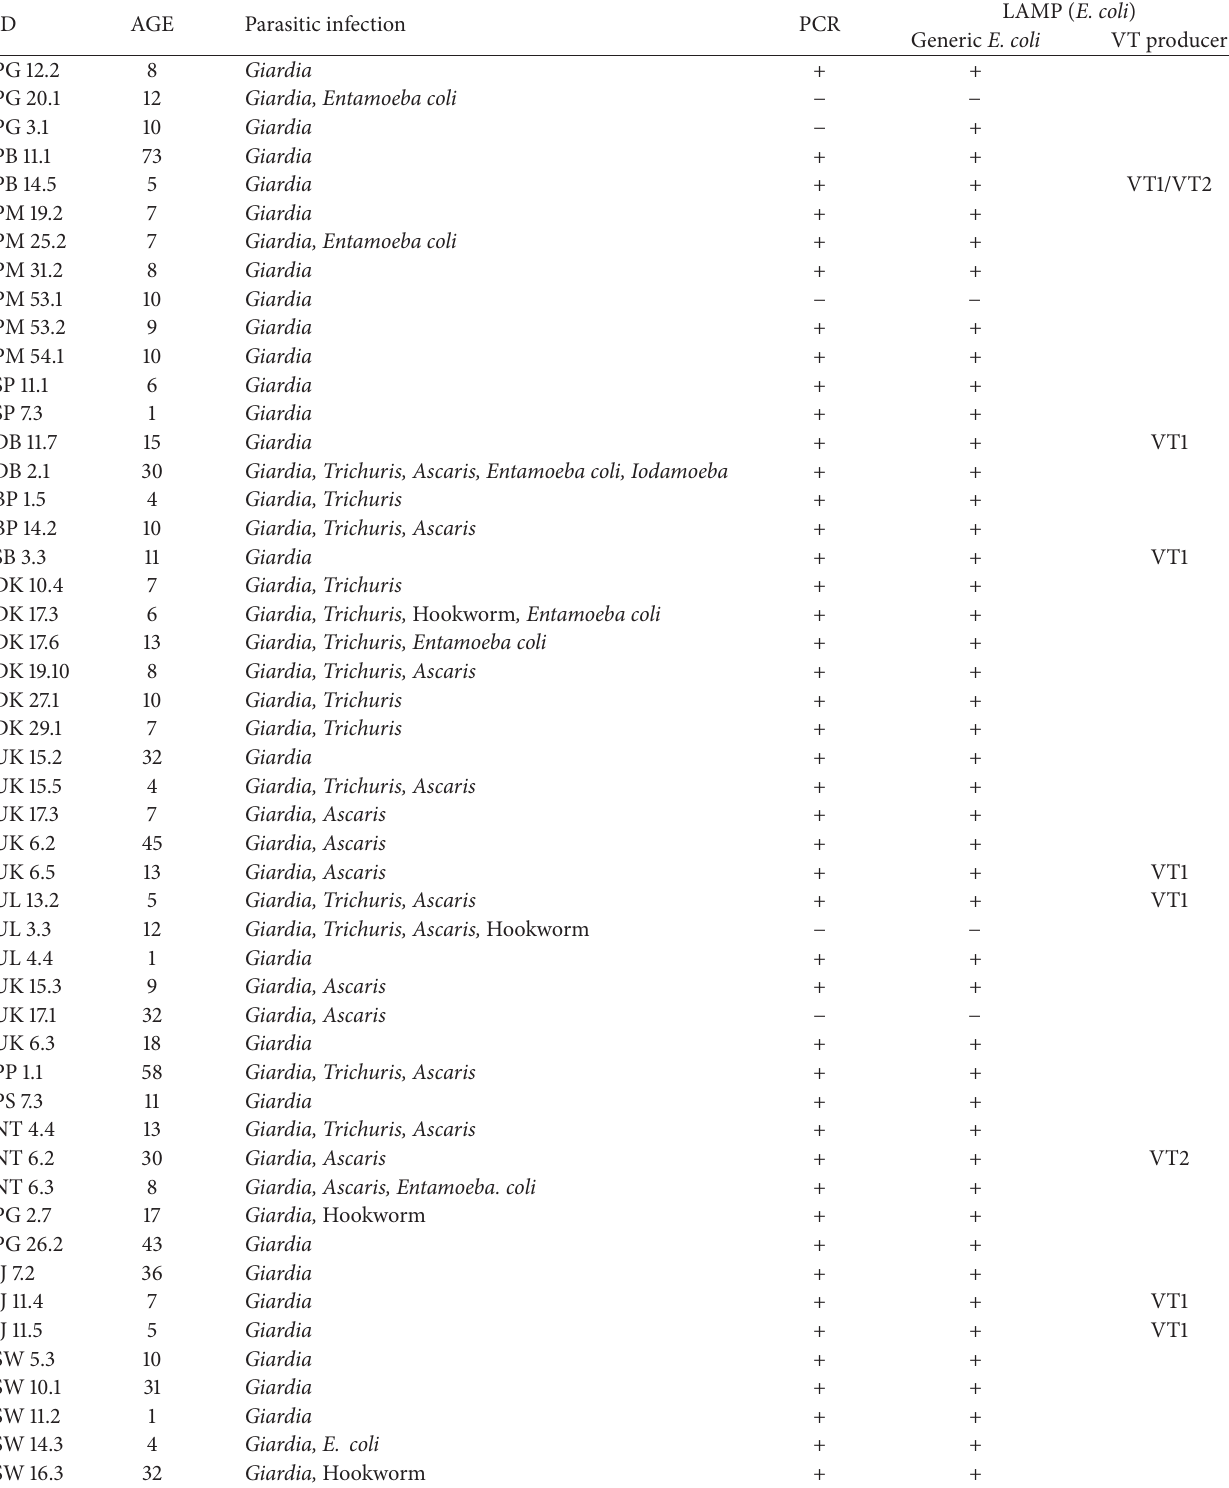
Table 1: PCR and LAMP results for the samples obtained from indigenous individuals which were previously detected with different parasitic